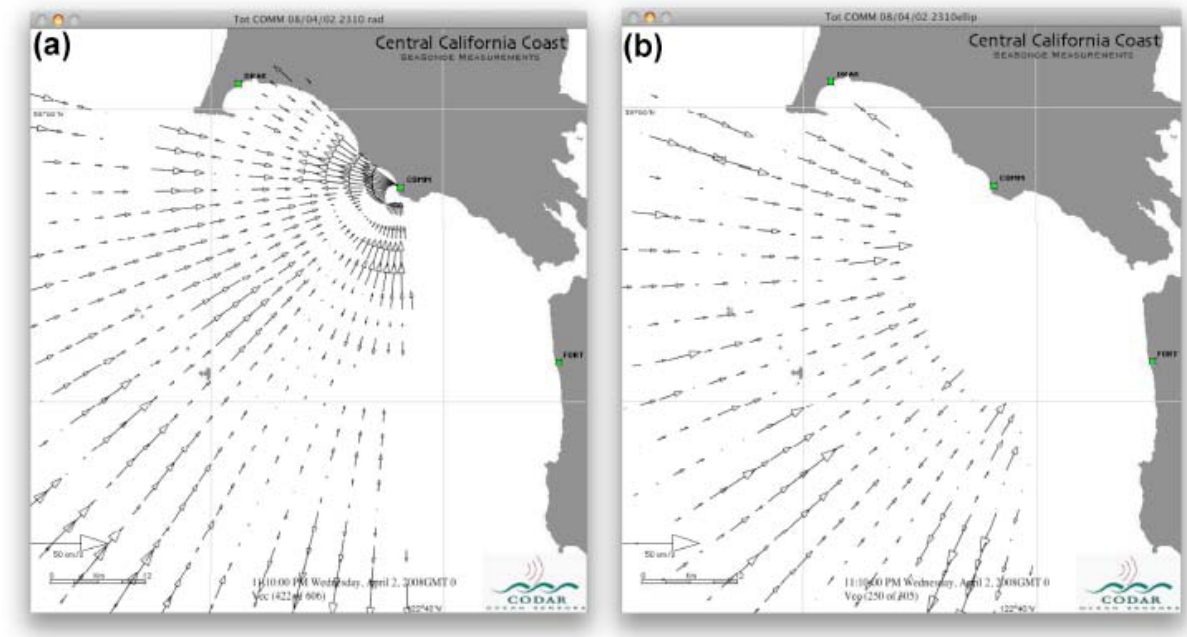
Figure 5. Radar current velocity maps produced by an HF radar located at Commonweal, California, on April 02, 2008, 23:10 from (a) backscatter; (b) bistatic echo from the transmitter at Fort